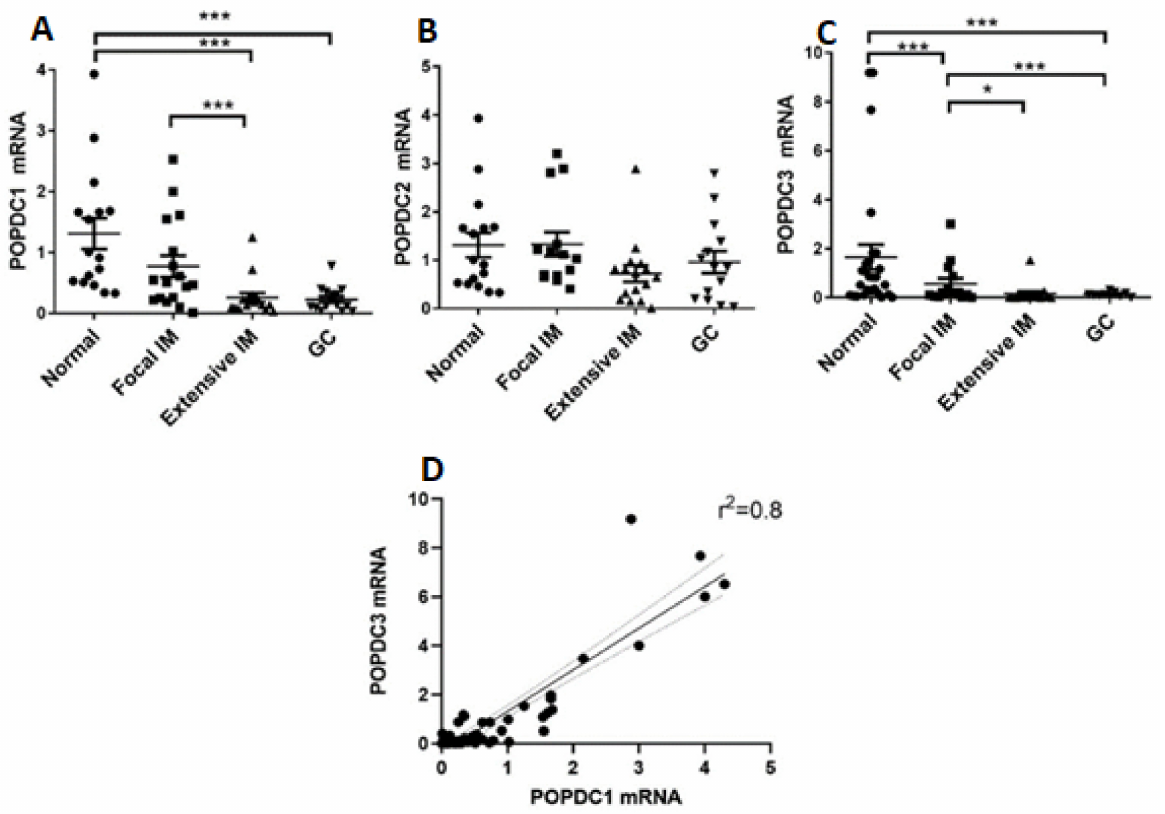
Figure 2. Expression of POPDC genes in the four gastric biopsy categories. A ( A – C ), Expression levels of POPDC genes in normal ( • ), focal IM ( (cid:4) ), extensive IM ( (cid:78) ), and GC ( (cid:72) ) biopsies as measured by qPCR. ( A ) POPDC1, ( B ) POPDC2, ( C ) POPDC3. Values of mRNA scores are in relative quantity (RQ) normalized to RPLP0 . Mean ± SEM. * p < 0.05; *** p < 0.001. ( D ) Correlation analysis between POPDC1 and POPDC3 in all the IM tissues. p <